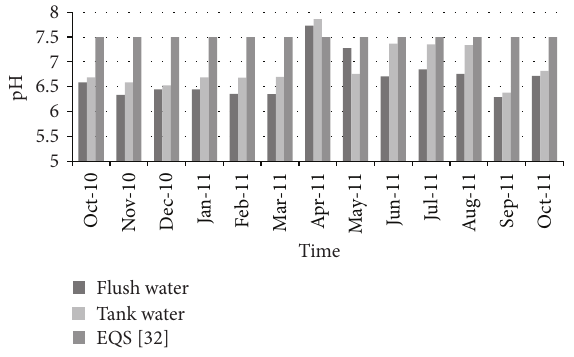
Figure 9: Variation of pH over time.